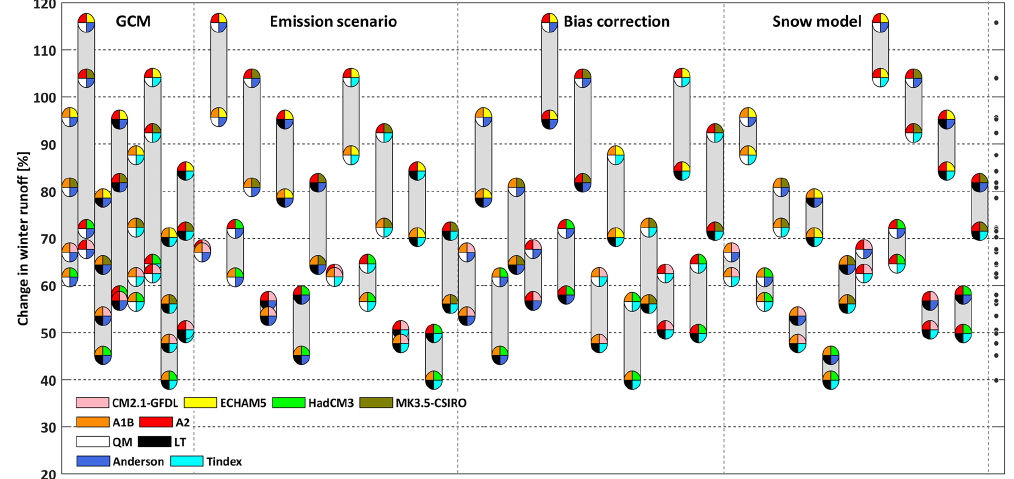
Figure 12. Uncertainty contributions are isolated for each of the four model components: GCM, emission scenario, bias-correction method and snow model (the approach is described in more detail in Section 3.4). The number of points in a bar corresponds to the number of members of the selected model component (e.g. four GCMs), while the number of bars is equal to the possible permutations based on the remaining three model components (2 × 2 × 2 =